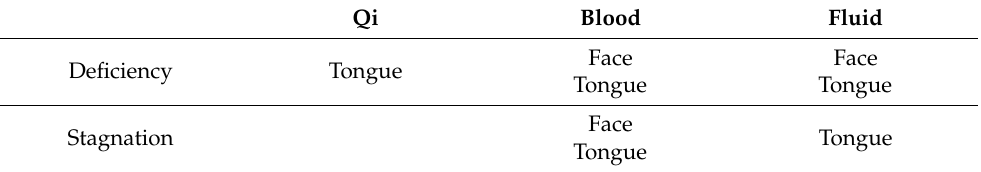
Table 1. Body parts (tongue and face) used to diagnose each of the six diseases in Kampo medicine. Deficiency Tongue Stagnation